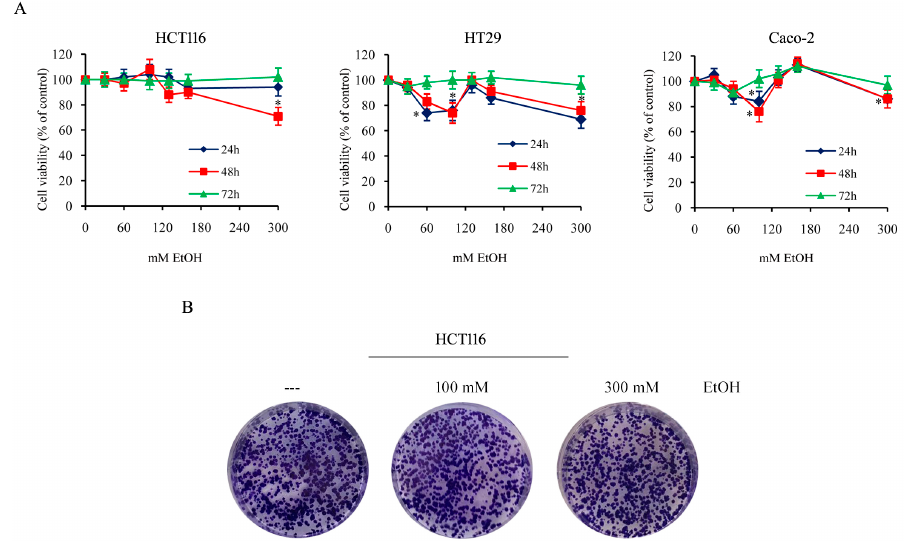
Figure 1. Ethanol effect on colon cancer cell viability and colony generation ability. ( A ) HCT116, HT29, and Caco-2 cells (7 × 10 3 ) were incubated in the presence of various doses of EtOH (30–300 mM) for the indicated times. Cell viability was assessed by 3-(4,5-dimethyl- thiazol-2-yl)-2,5-diphenyltetrazolium bromide (MTT) assay and expressed as the percentage of the viable control cells in untreated cultures. Values are the means of three independent experiments ± S.E. (*) p < 0.05 compared to the control. ( B ) The clonogenic assay was performed seeding a single cell suspension (200 cells/well) in 6-well plate and after 48 h treating it with different doses of EtOH. Clonogenic ability was evaluated after 14 days. Photographic images of cells after staining with crystal violet were reported. Results are representative of three independent